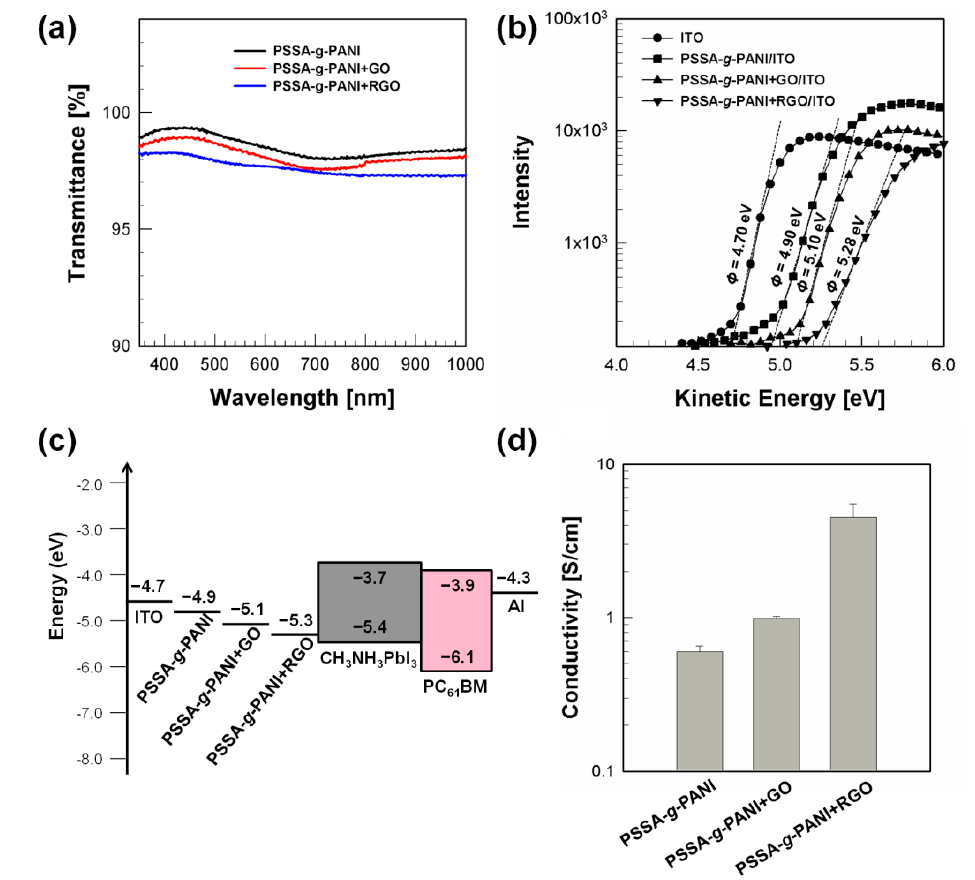
Figure 1. ( a ) Transmittance spectra, ( b ) UPS kinetic energies, ( c ) energy level diagram, and ( d ) electrical conductivities of the composite films in PSCs.